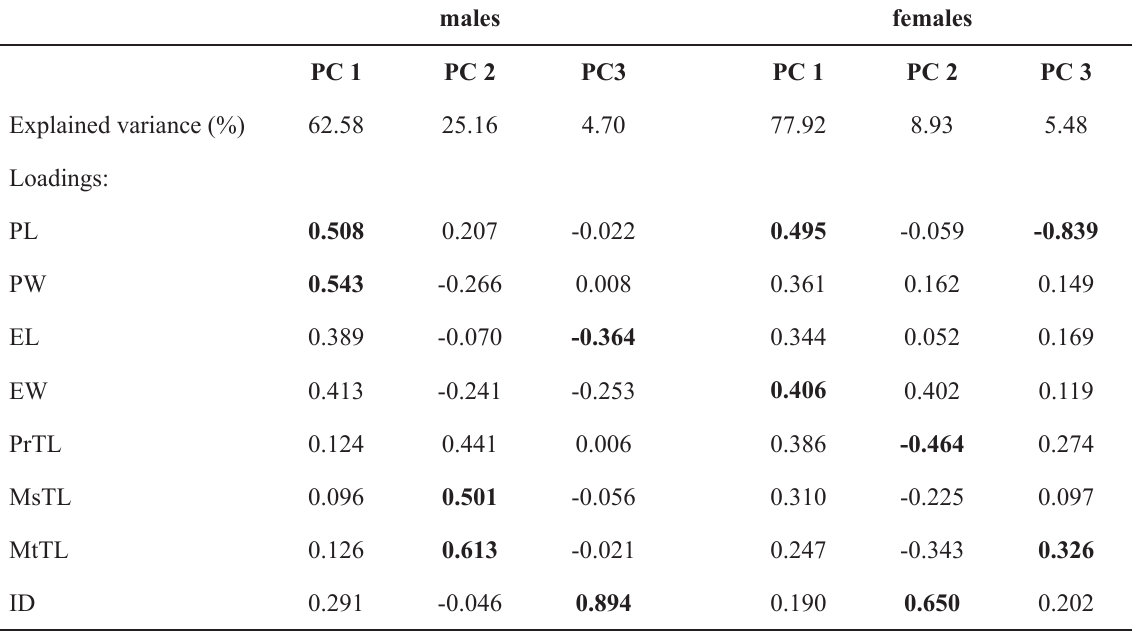
Table 3. Explained variance and loadings onto the first three principal components for males and females of Elmomorphus brevicornis Sharp, 1888 and Elmomorphus amamiensis Nomura, 1959. Loadings with first and second highest absolute values in each component are in boldface.